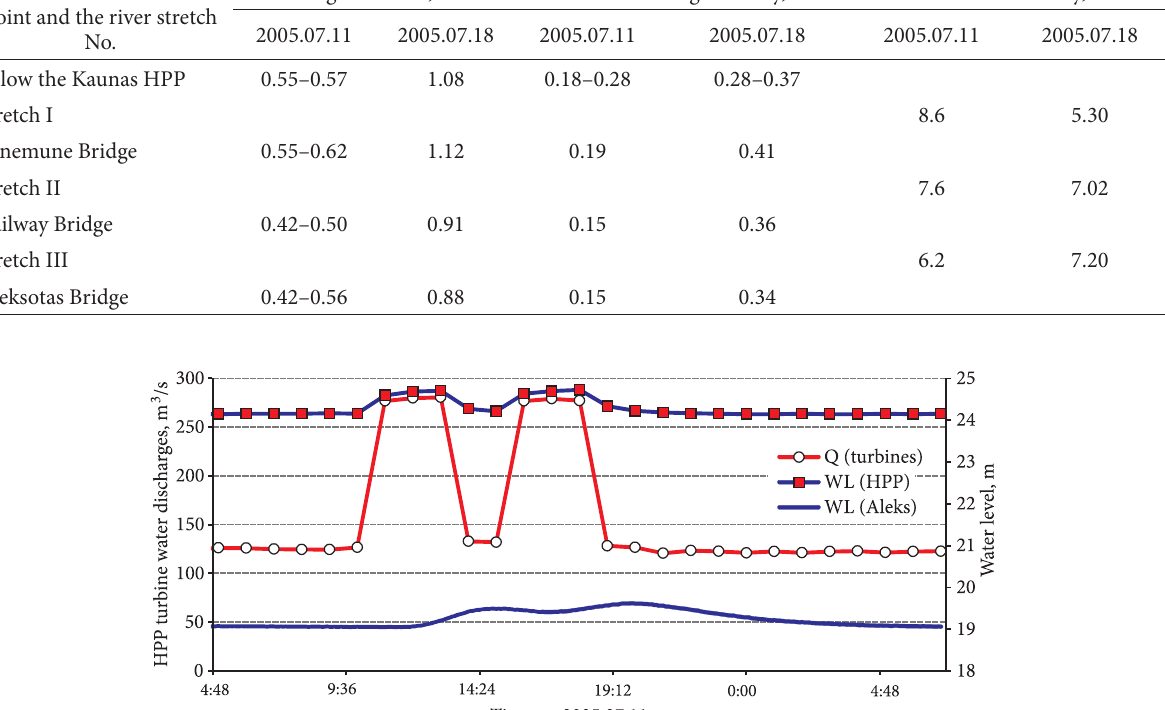
Table 1. Flux wave parameters calculated using the measured water levels Position of measurement point and the river stretch